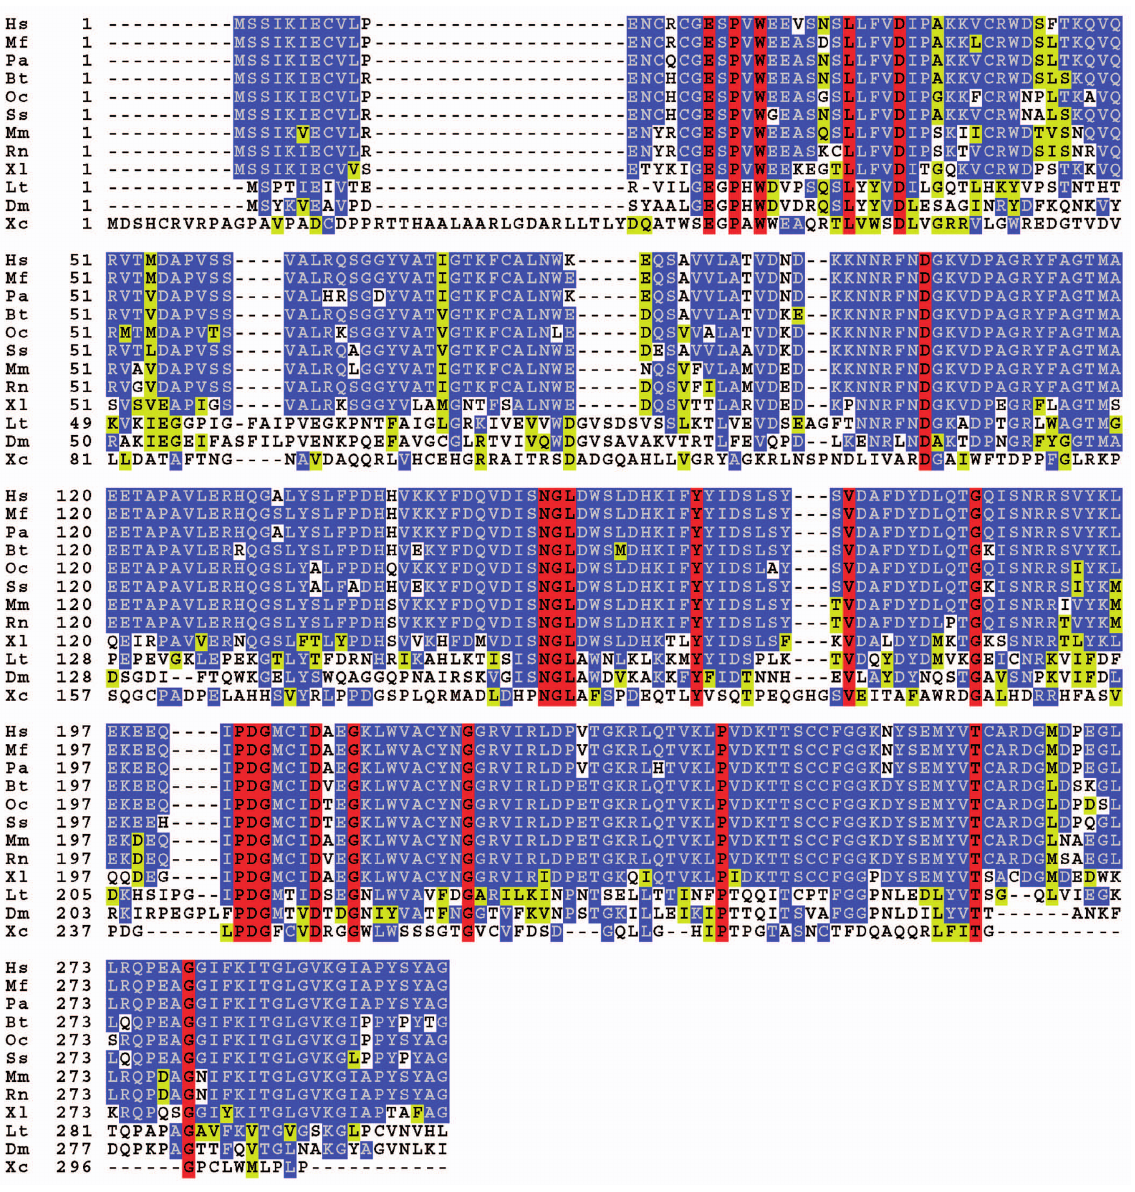
Figure 1 Amino acid sequence alignment of SMP30 homologs in vertebrates and invertebrates. Red indicates completely conserved, blue indicates identical, and yellow indicates similar residues. Identity between vertebrates ranges from 70% to 90%, and drops to about 30% between vertebrate and invertebrate forms of SMP30. The amino acid sequence of SMP30 is highly conserved among all mammals, regardless of the ability to synthesize ascorbate. Latin and common names as well as GI accession numbers for the above represented species are as follows: Hs, Homo sapiens , human, 23111021; Mf, Macaca fascicularis , monkey, 115502619; Pa,